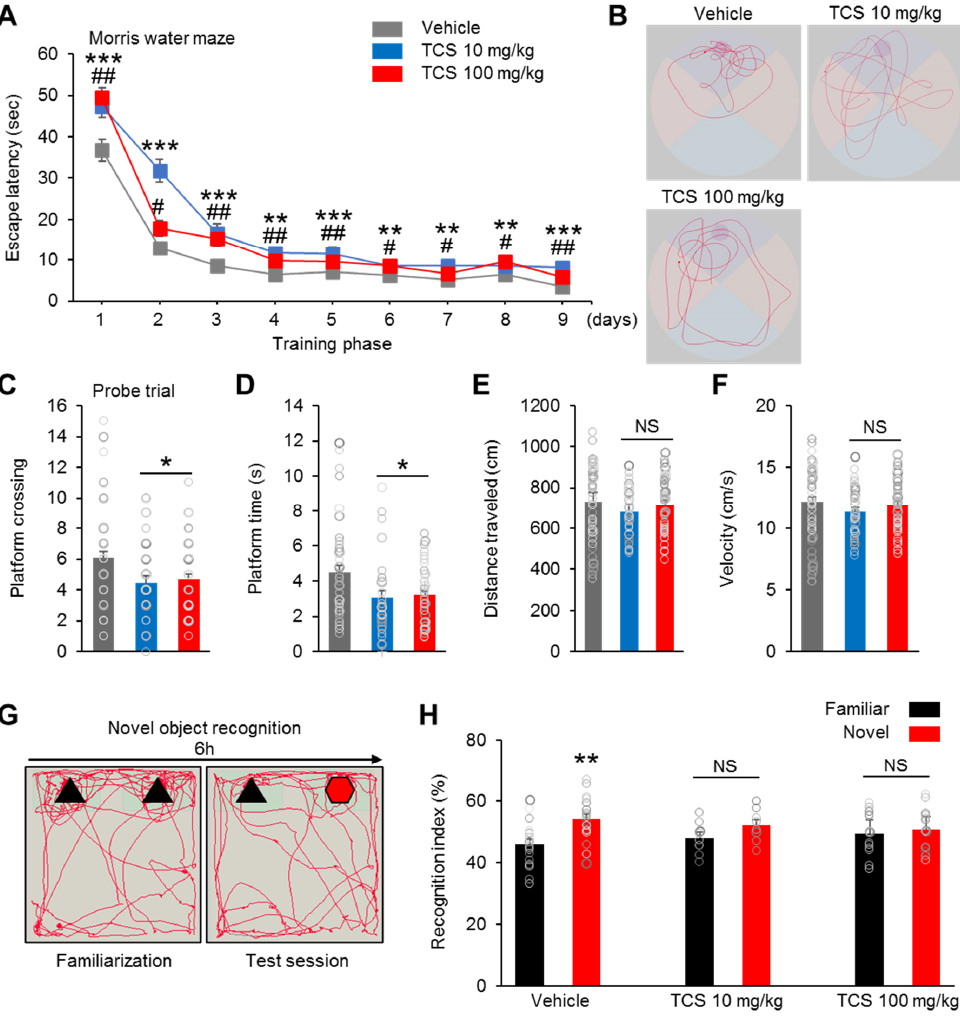
Figure 3. TCS impaired learning and recognition memory in mice. ( A ) In Morris water maze test, TCS- treated groups exhibit spatial learning disability; n = 18 mice (7 male, 11 female) for vehicle, 11 mice (8 male, 3 female) for TCS 10 mg/kg, 17 mice (10 male, 7 female) for TCS 100 mg/kg. ( B ) Representative swimming paths of vehicle, TCS 10 mg/kg and TCS 100 mg/kg during a probe trial after training. ( C , D , E , and F ) Quantification of B . TCS 10 mg/kg and TCS 100 mg/kg group showed a decrease in platform crossings and time spent in platform. TCS-treated groups showed no change in swimming distances and swimming speeds. * p < 0.05 vehicle vs. TCS 10 mg/kg, ** p < 0.01 vehicle vs. TCS 10 mg/kg, *** p < 0.001 vehicle vs. TCS 10 mg/kg. # p < 0.05 vehicle vs. TCS 100 mg/kg, ## p < 0.01 vehicle vs. TCS 100 mg/kg. NS, no significance. ( G ) Schematic diagram of the novel object recognition test. ( H ) Novel object test shows recognitive impairment in TCS-treated groups. n = 18 mice (7 male, 11 female) for vehicle, 9 mice (6 male, 3 female) for TCS 10 mg/kg, 14 mice (8 male, 6 female) for TCS 100 mg/kg. Data represent mean ± SEM. Statistical significance was determined by two-way ANOVA. ** p < 0.01 familiar vs. novel object. NS, no significance. Treatments: corn oil; vehicle, TCS; 10 mg/kg/day, TCS; 100 mg/kg. With regard to the time spent on each object, we found that the vehicle group spent more time approaching and in proximity to the novel object (vehicle; Familiar = 45.97 ± 1.71, vehicle; Novel = 54.03 ± 1.71, t = 3,339, p = 0.0021) (Figure 3H). In contrast, both the TCS 10 mg/kg and TCS 100 mg/kg groups showed no preference for exploring either the familiar or the novel object (TCS 10